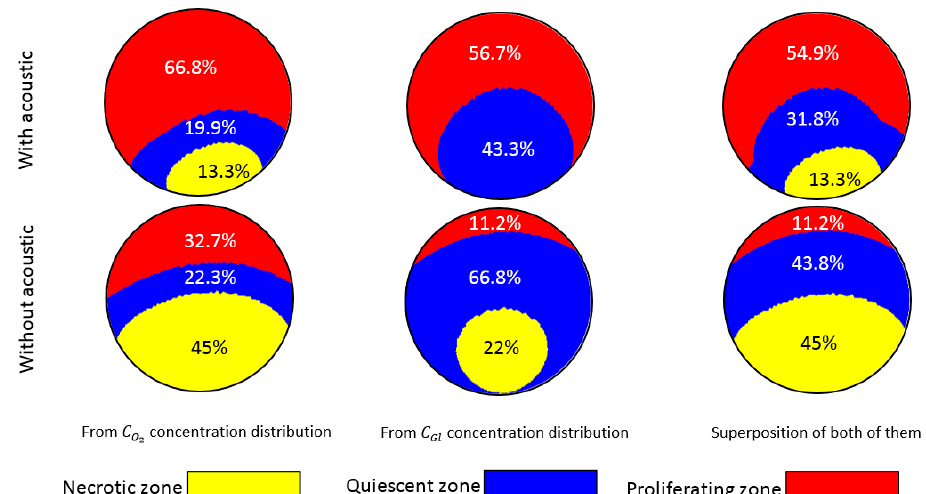
Figure 9. Distribution of glucose and oxygen with and without acoustics. This figure aims to show how oxygen (left column) and glucose (middle column) solely contribute to the formation of necrotic and quiescent zones. Without acoustics, the shortage of oxygen leads to a 32.7% proliferation zone (bottom-left), while this is only 11.2% for glucose (bottom-center). The huge loss of the proliferation zone is mainly due to the large quiescent zone (66.8%) caused by the lack of glucose. The combinatorial effect is 11.2% of proliferating zone, 43.8% quiescent zone, and 45% necrotic zone (bottom-right). With acoustics, the necrotic zone from glucose shortage is omitted completely and is decreased to 13.3% from the lack of oxygen. The quiescent zones of oxygen and glucose are also reduced in size, and consequently, a noticeable improvement in the combinatorial share of the proliferating zone is observed (54.9%, top-right).